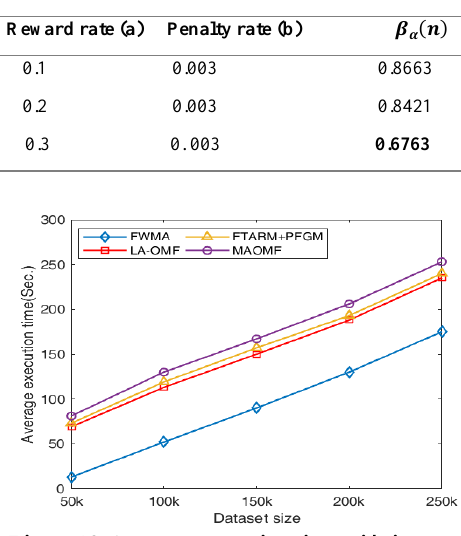
Table 11. Change of to increase a .